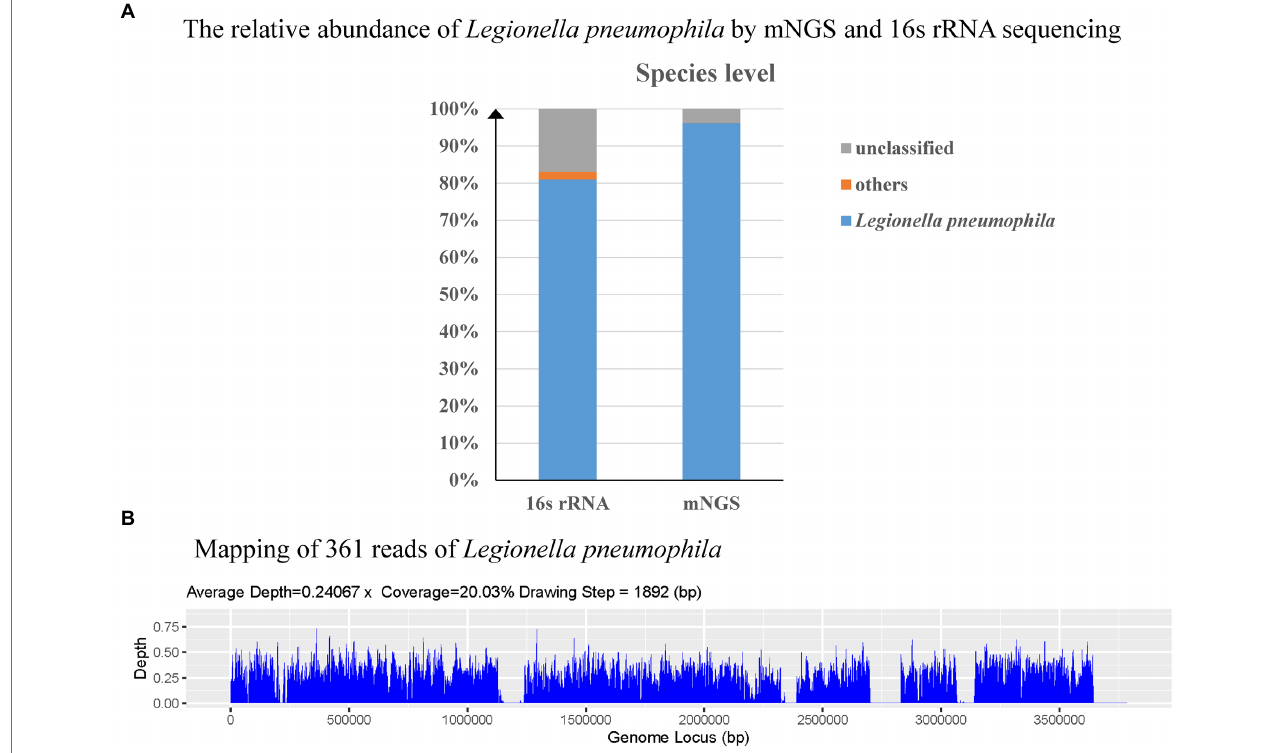
FIGURE 3 | Diagnosis of L. pneumophila infection by means of Unbiased Next-Generation Sequencing (mNGS) and 16s ribosomal RNA (rRNA) sequencing. The relative abundance of L. pneumophila from the patient’s bronchoalveolar lavage fluid (BALF) by mNGS and 16s rRNA sequencing (A) . Sequence reads mapped to L. pneumophila by mNGS data (B)